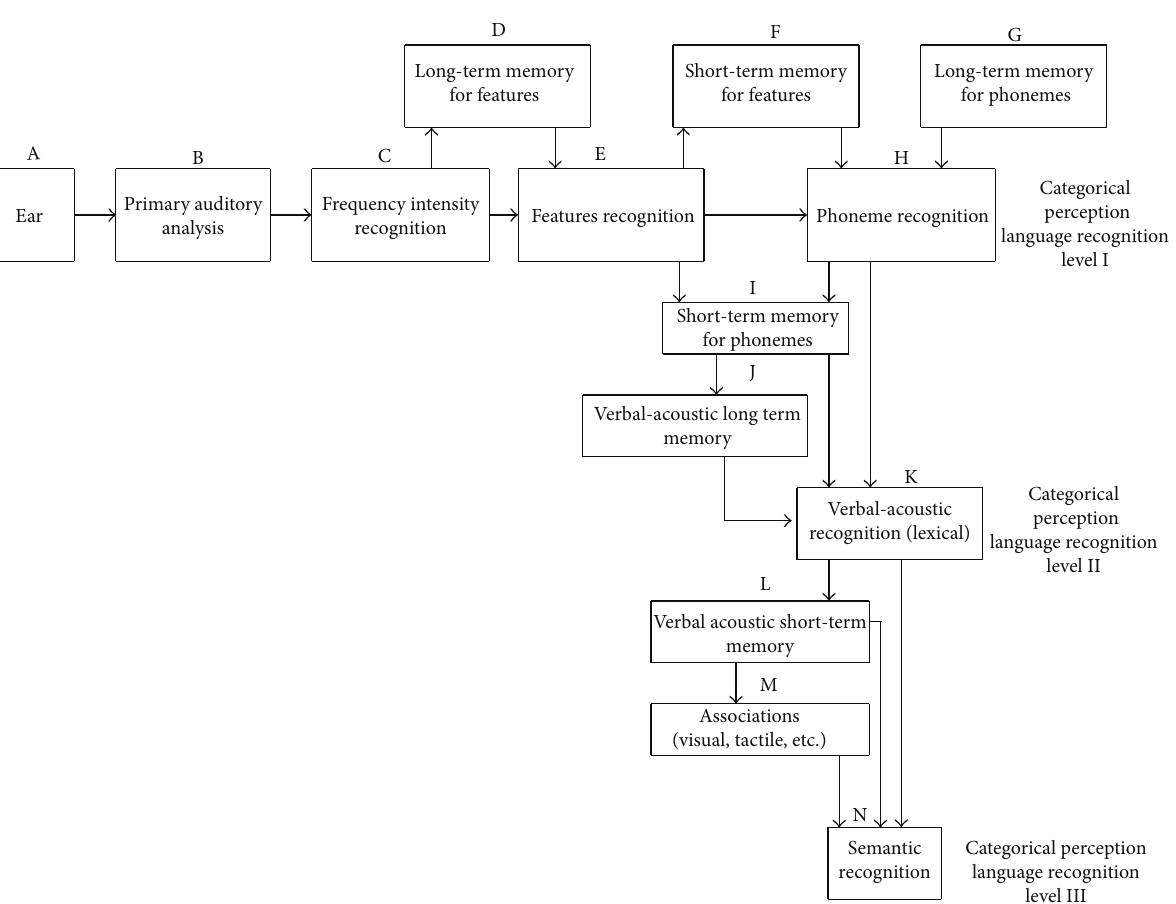
Figure 2: Diagram model for language recognition proposed by Ardila [33]. Three levels of language recognition potentially impaired in Wernicke-type aphasia can be distinguished: phonemic (categorical perception level I), lexical (categorical perception level II), and semantic (categoricalperceptionlevelIII).Threedifferentsubsyndromescanbefound:phonemicdiscriminationdefects(acoustic-agnosicorWernicke aphasia type I), verbal-acoustic memory defects (acoustic amnesic or Wernicke aphasia type II), and semantic association defects (amnesic, nominal, or Extrasylvian sensory